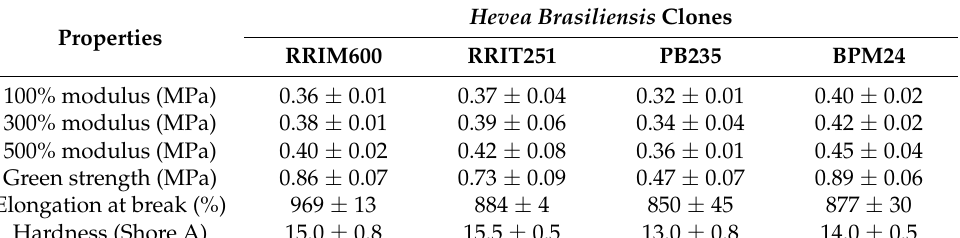
Table 5. Mechanical properties of NR from fresh natural latex collected from four different Hevea brasiliensis clones.